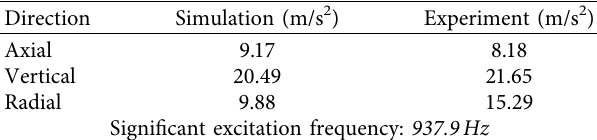
Figure 6: Radial acceleration of the original Table 3: Comparisons between simulations and the test.